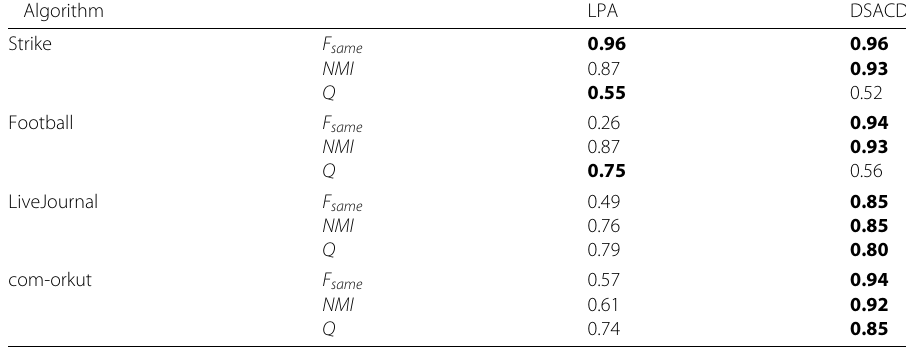
Table 8 Comparison with other community discovery algorithm cluster results